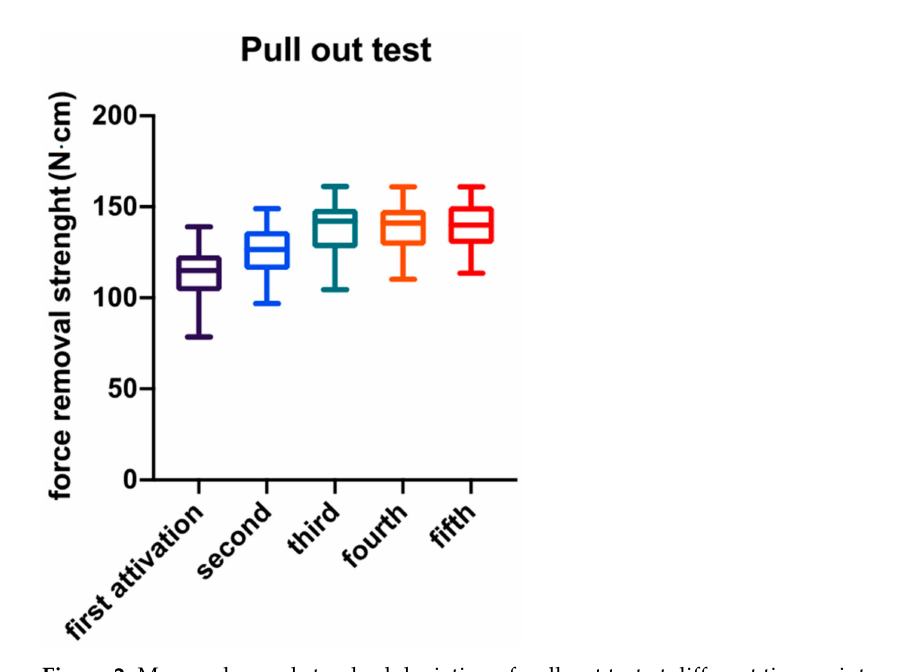
Figure 2. Mean value and standard deviation of pull-out test at different time points. Table 1. Descriptive statistics of pullout test.